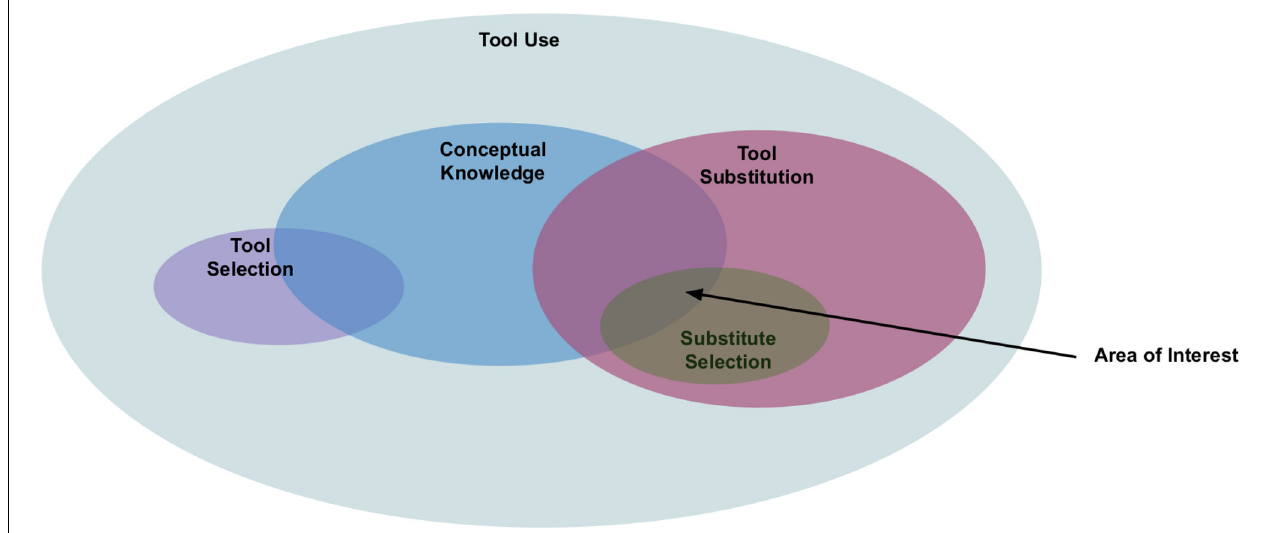
FIGURE 1 | The figure shows our primary area of interest within the domain of tool-use. Conceptual knowledge is desirable in tool use, however our focus is on generating conceptual knowledge required for substitute selection. The figure also illustrates the positioning of substitute selection within tool-use. While tool-use also consists of areas such as grasping, planning, manipulation, validation etc. we have left them out for the sake of clarity. Besides our primary area of interest, our intent is to distinguish it from tool-use or tool selection. Note that in tool selection a robot does not have any prior knowledge of what is tool is appropriate in a given task whereas in substitute selection, the robot does have such prior